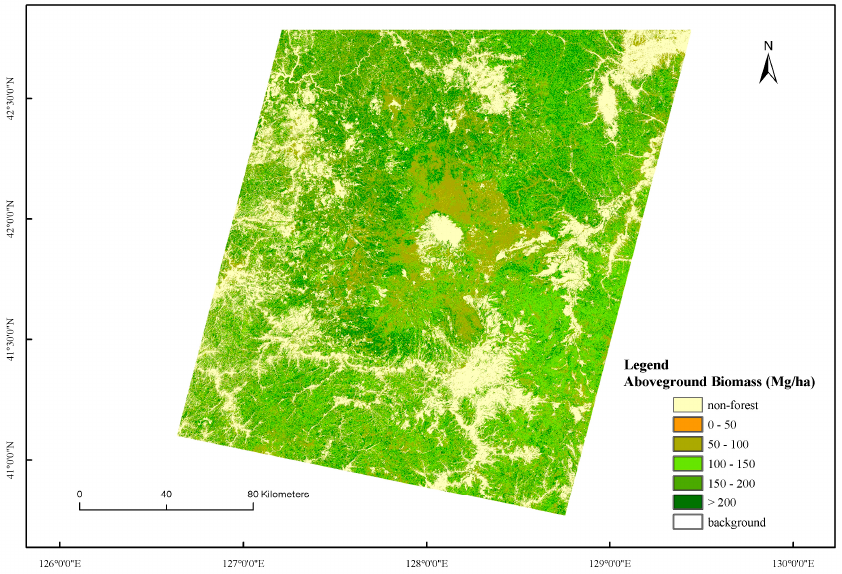
Figure 4. Map of AGB in the Changbai Mountain region.